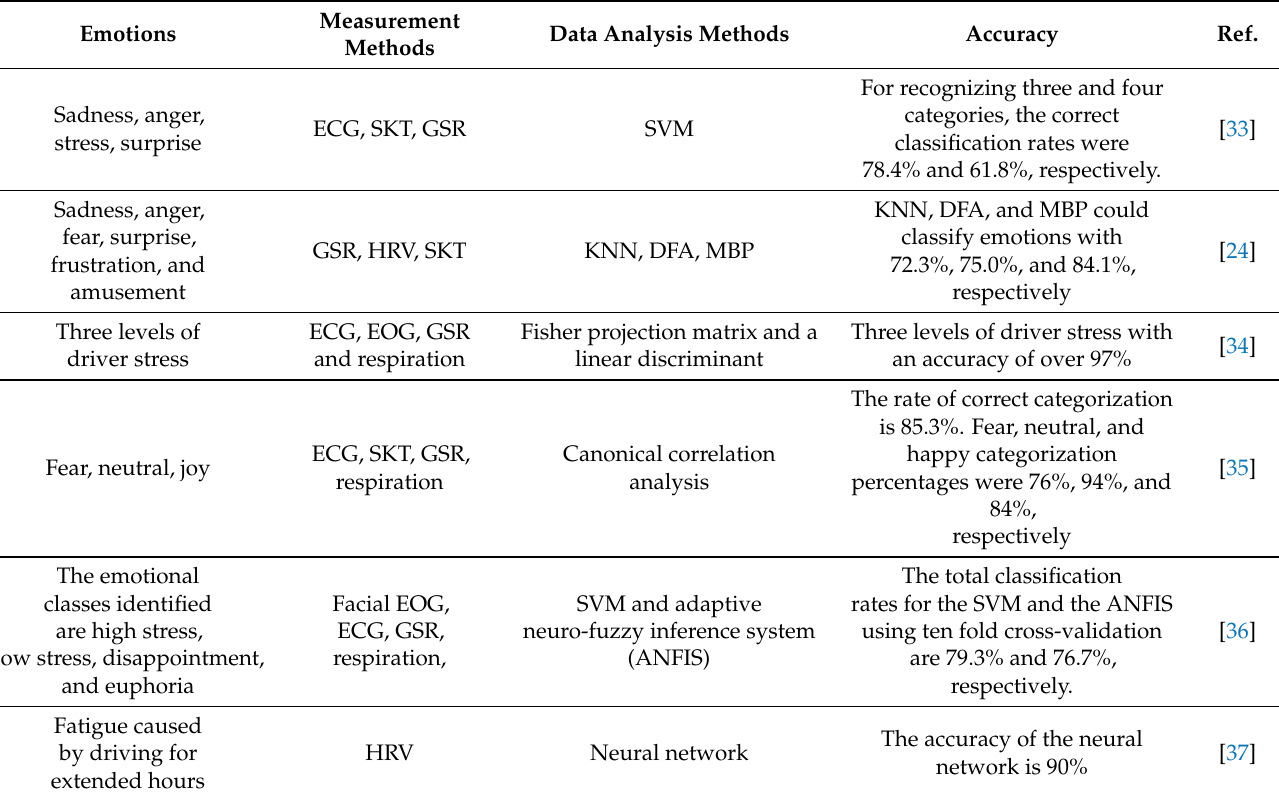
Table 2. Previous Research on Recognizing Emotion from Physiological Signals and Facial